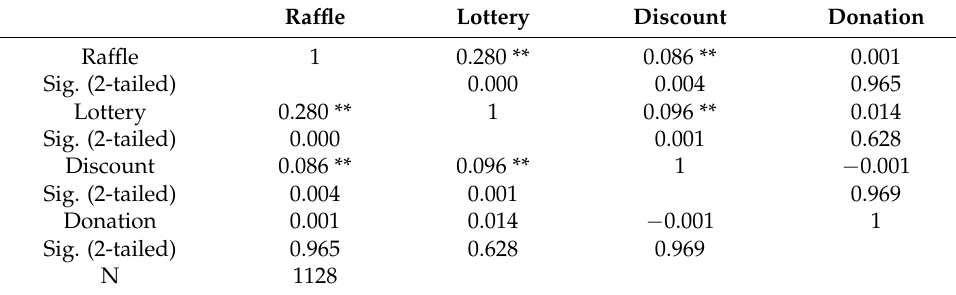
Table 4. Relationships between type of users by incentives (Pearson correlation).